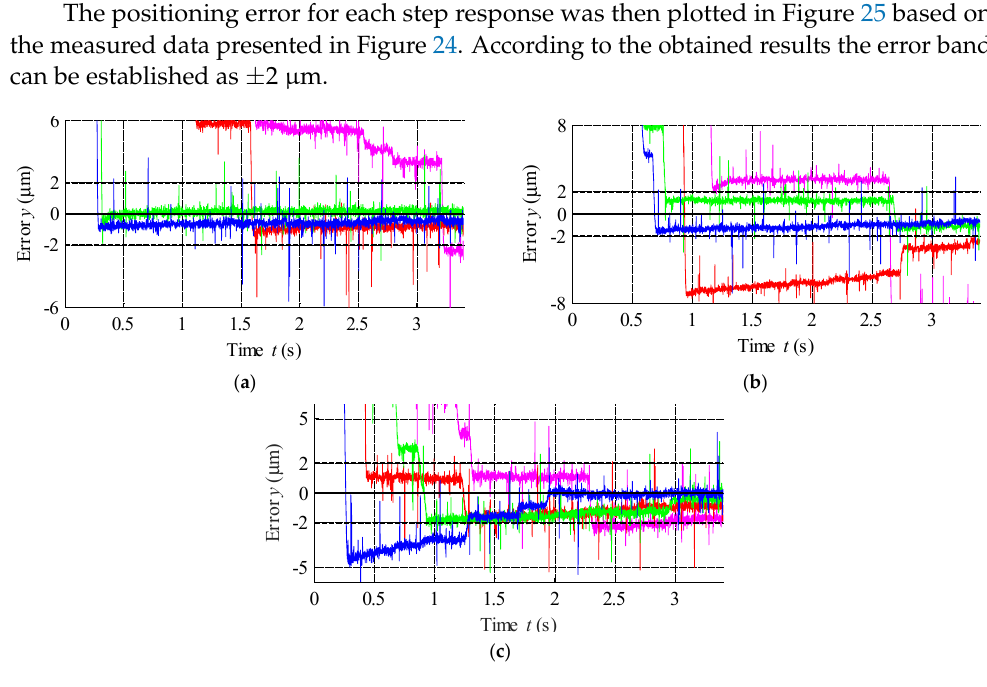
Figure 25. Positioning error for the step responses presented in Figure 24: ( a ) 1000 µm, ( b ) 750 µm and ( c ) 500 µm.